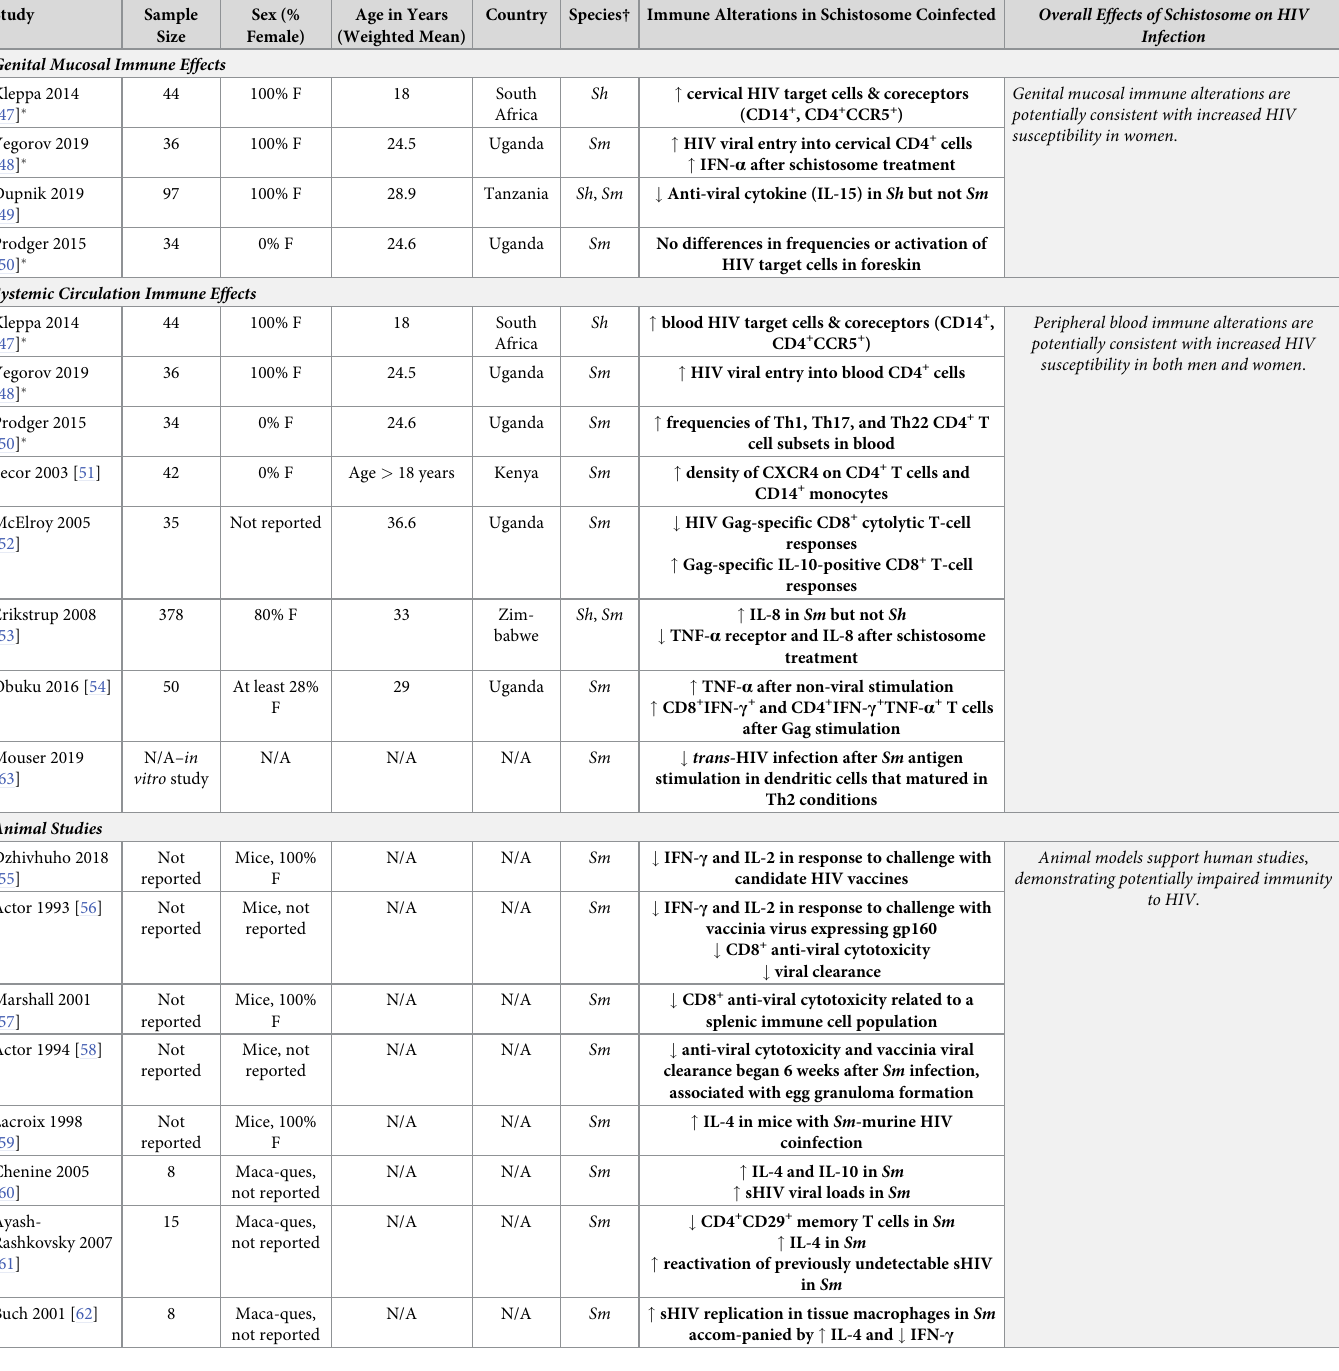
Table 3. Effects of Schistosome Infection on Host Immune Response to HIV in the Genital Mucosa and Systemic Circulation. Study Sample Size